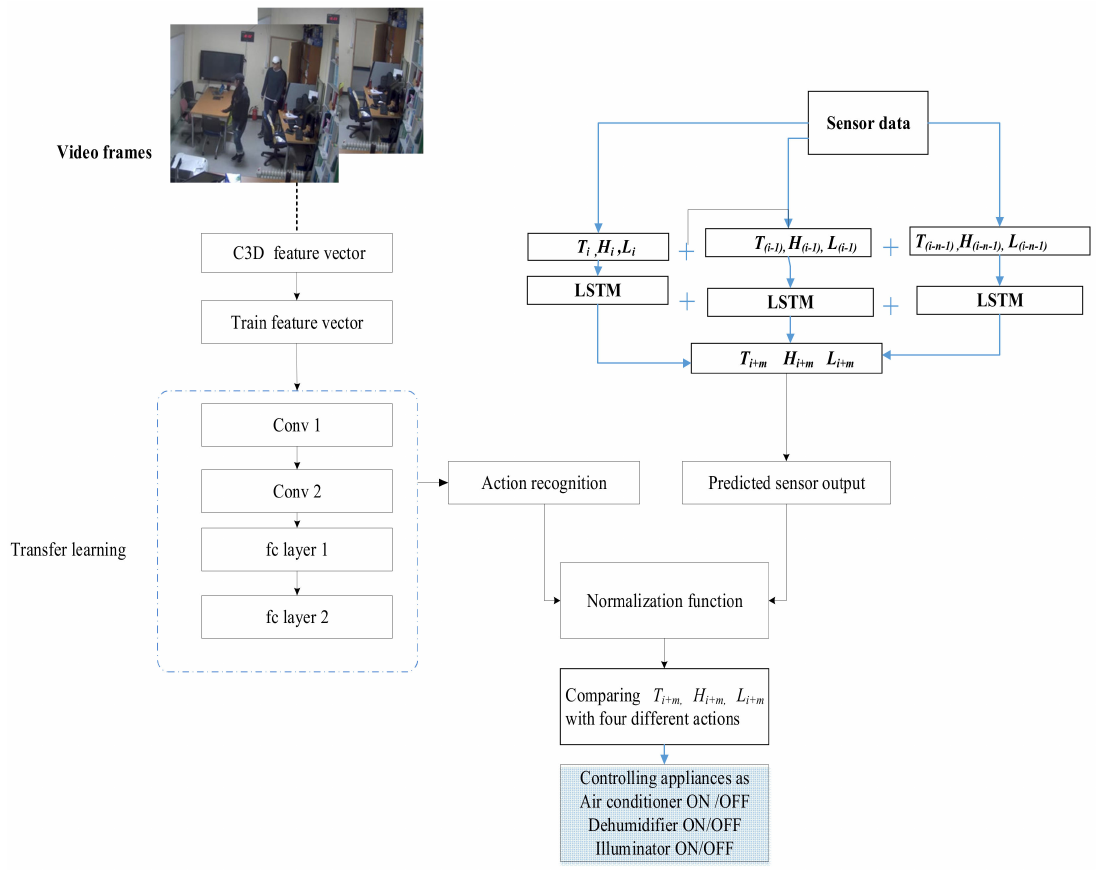
Figure 4. Context-aware network with transfer learning combining video and sensors